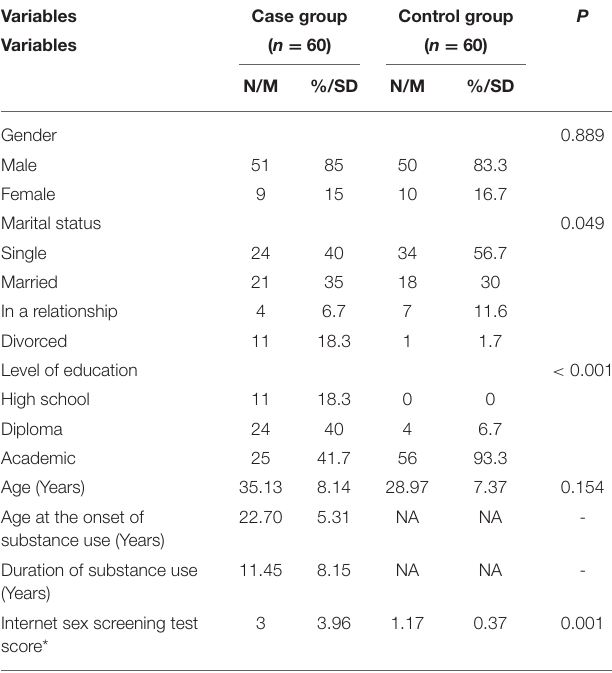
TABLE 1 | Characteristics of the study sample ( n =